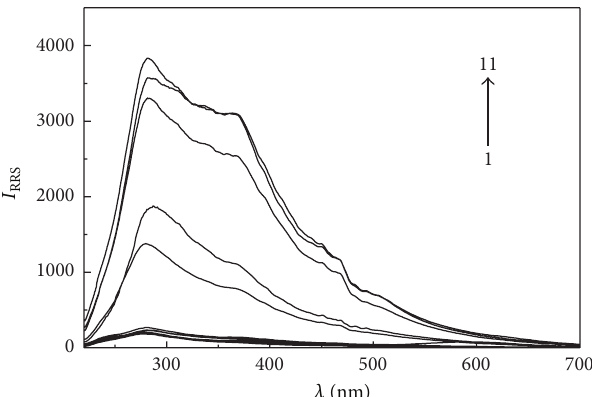
Figure4:Effectofacidityon Δ𝐼 .HSAconcentrations:2.5 𝜇 g/mL; RRS CdS concentration: 6.0 × 10 −5